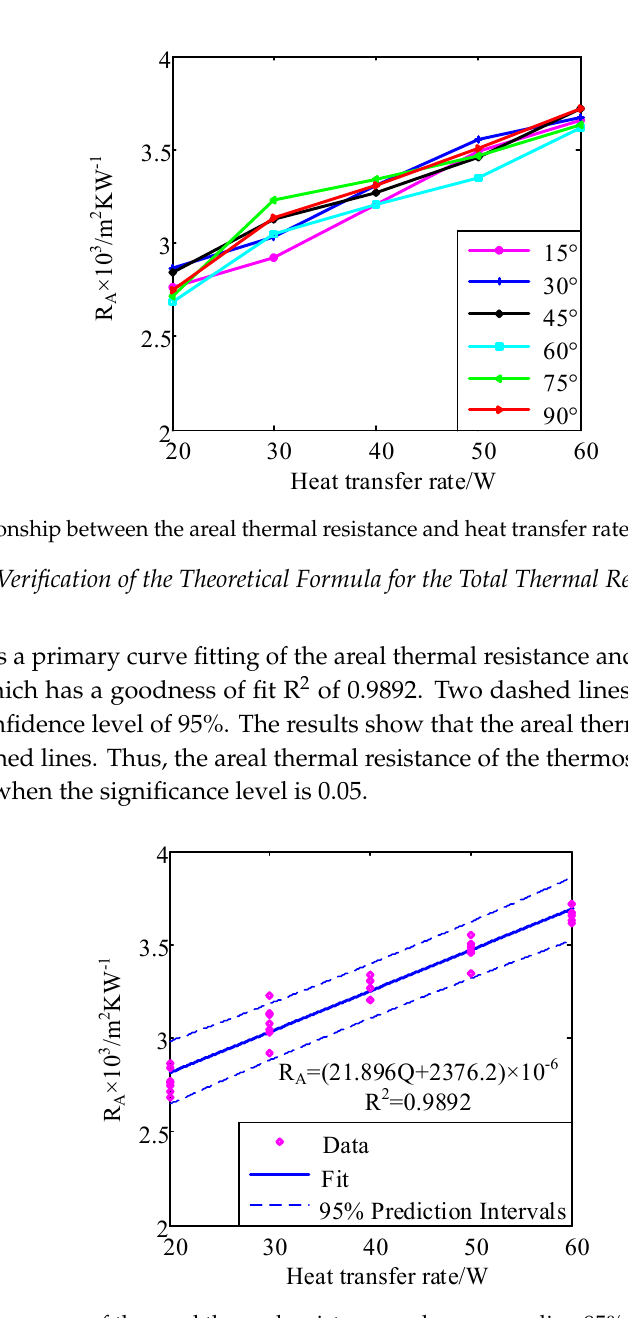
Figure 6. Relationship between the total thermal resistance and heat transfer rate of the thermosyphon.